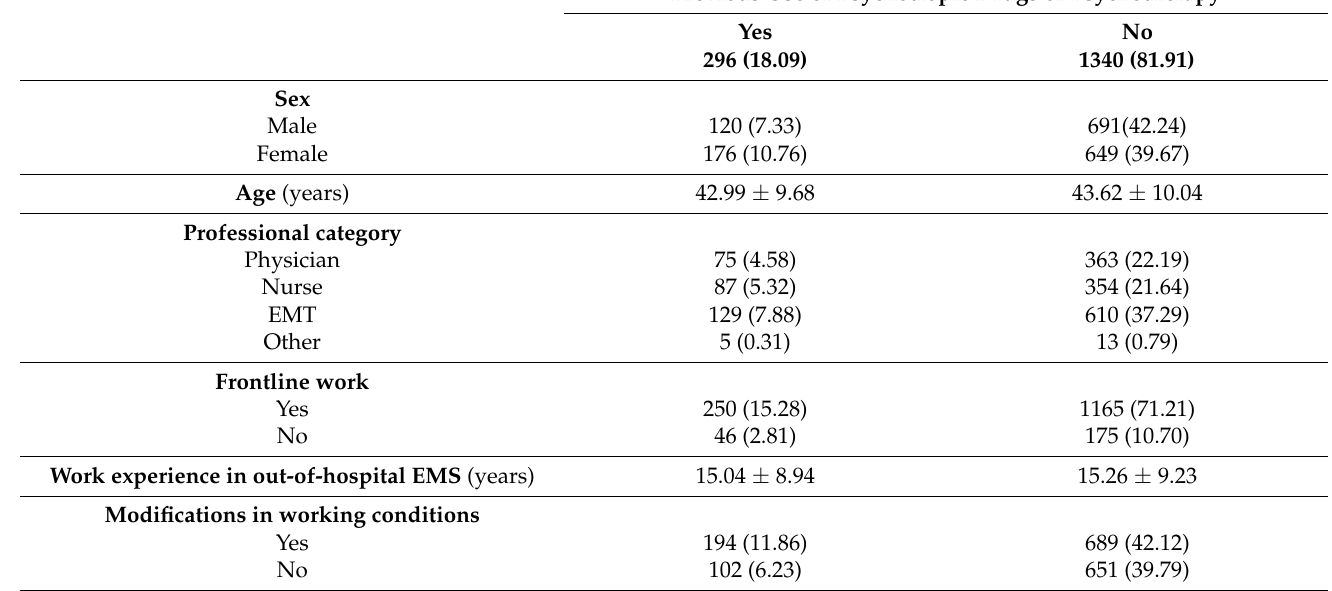
Table 1. Descriptive characteristics of the sample based on the previous use of psychotropic drugs or psychotherapy.